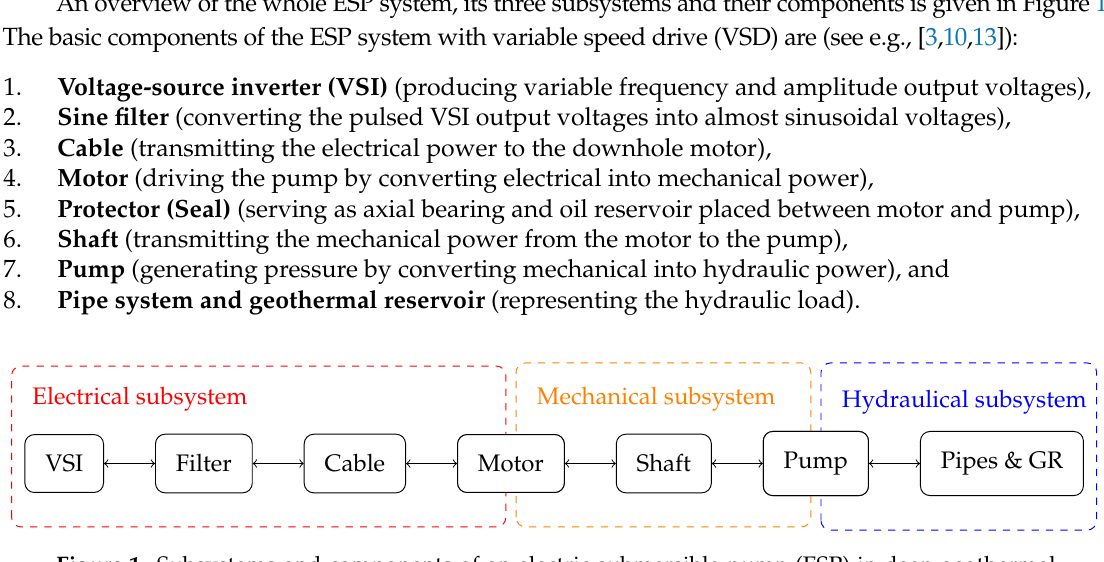
Figure 1. Subsystems and components of an electric submersible pump (ESP) in deep geothermal energy applications (GR = geothermal